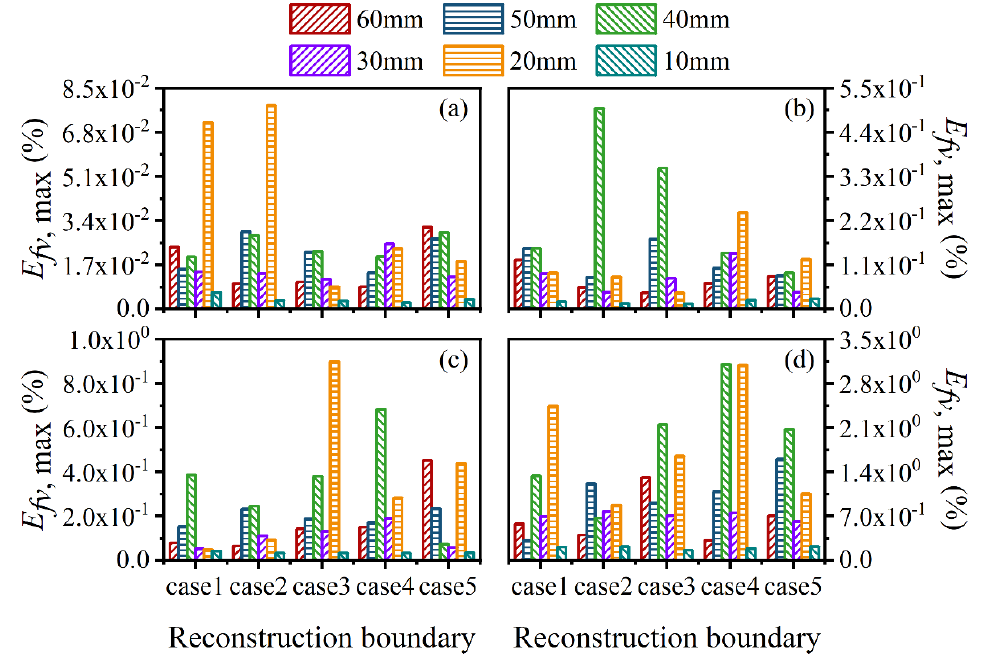
Figure 25. The maximum relative reconstruction error for soot volume fraction with different SNR considering different reconstruction boundaries. ( a ) SNR = 80 dB; ( b ) SNR = 65 dB; ( c ) SNR = 60 dB; ( d ) SNR = 46 dB.